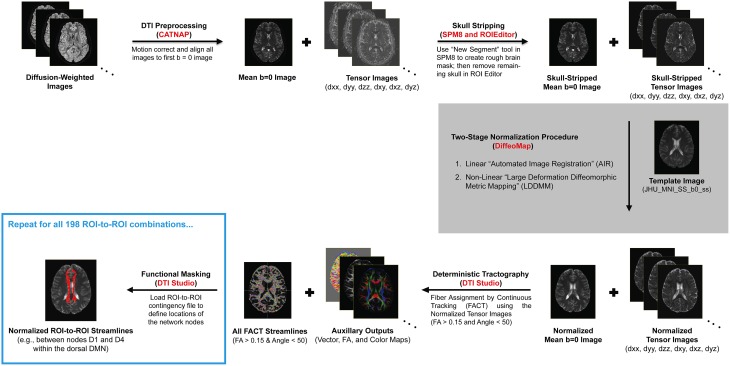
Illustration of our DTI processing pipeline for each subject, which included multiple steps (black arrows) and made use of several different software packages (shown in red). After motion correcting and realigning the raw data, the mean b = 0 (s/mm2) and six tensor images were calculated, skull-stripped, and normalized to a standard anatomical template (i.e., the “JHU_MNI_SS_b0_ss” template in MRIStudio). Whole-brain fiber tracking was then performed to compute all of the streamlines in the brain—with fractional anisotropy (FA) > 0.15 and deviation angle < 50°—before implementing a multi-ROI approach (i.e., using the “Cut” operation in DTIStudio) to identify subsets of these entering or passing through pairs of nodes in each functionally-connected brain network (Shirer et al., 2012).